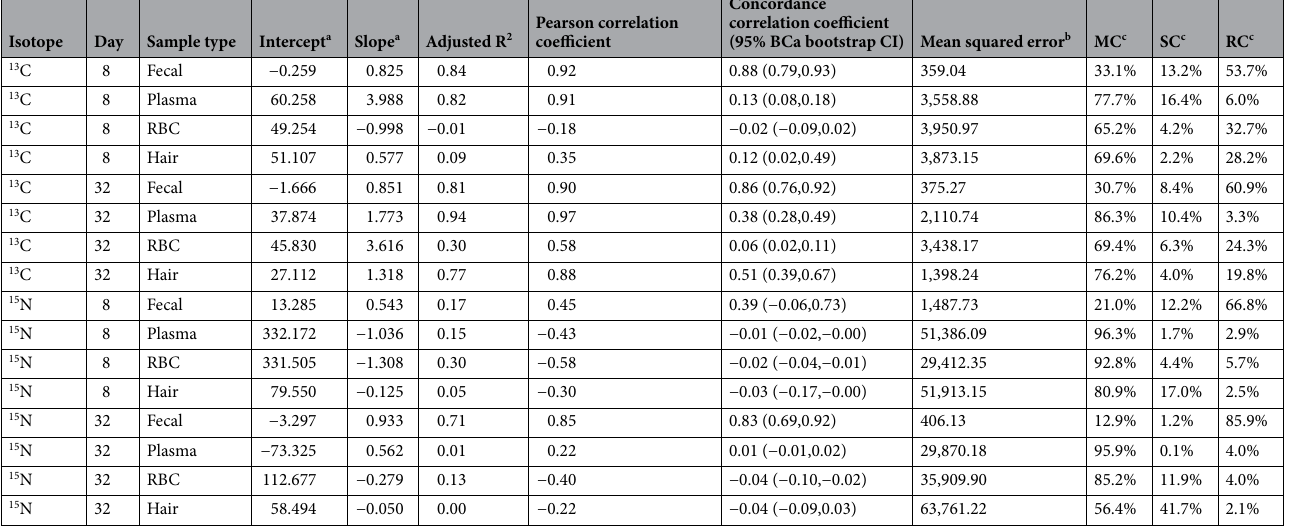
Table 3. Analytic regression analysis results for 16 combinations of isotope ( 13 C or 15 N), day (8 or 32), and sample type (feces, plasma, red blood cell (RBC), or hair). BCa bias accelerated and corrected. a From a model regressing actual on predicted dietary proportions. Ideal intercept value is 0.0, ideal slope value is 1.0. b Mean squared error where ‘error’ is the predicted minus actual dietary proportion. c MC, SC, RC are mean, slope, random components of the MSE (as